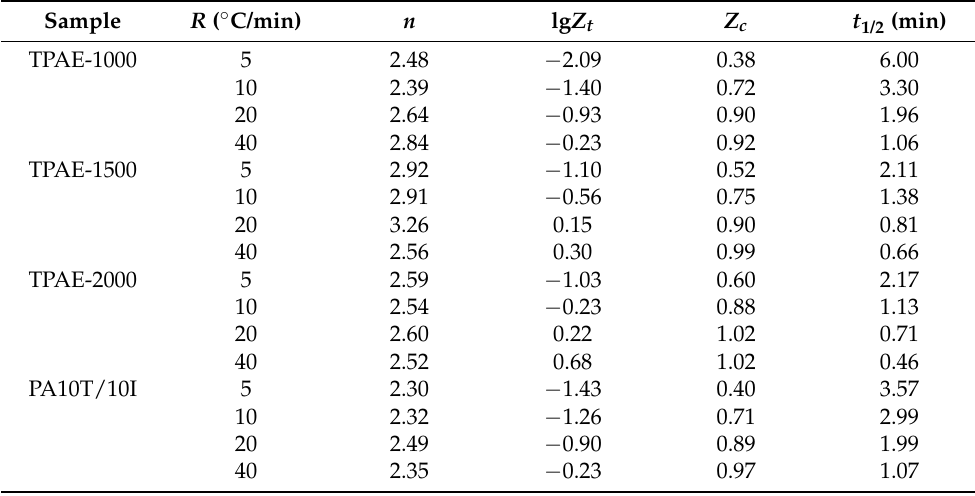
Figure 11. Plots of lg[ − ln(1-Xt/100)] vs. lgt for TPAE-1000 ( a ), TPAE-1500 ( b ), TPAE-2000 ( c ) and PA10T/10I ( d ). Table 5. Crystallization kinetic parameters from Avrami’a model.